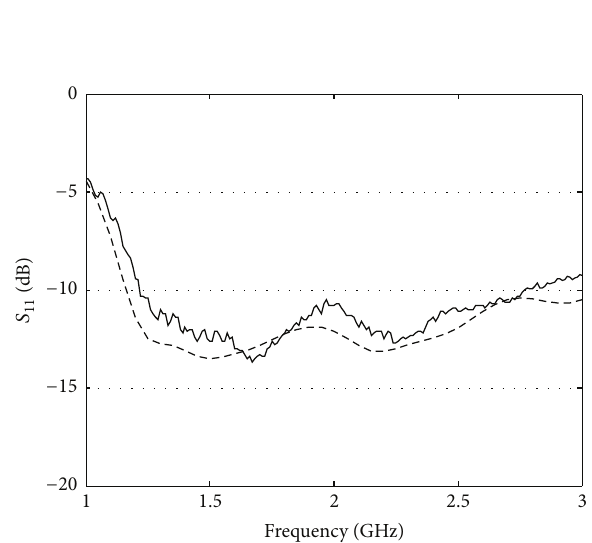
Figure 7: Reflection coefficient ( 𝑆 11 ) against frequency of the proposed strip-helical antenna. Solid line: measured data; dashed line: simulated data.